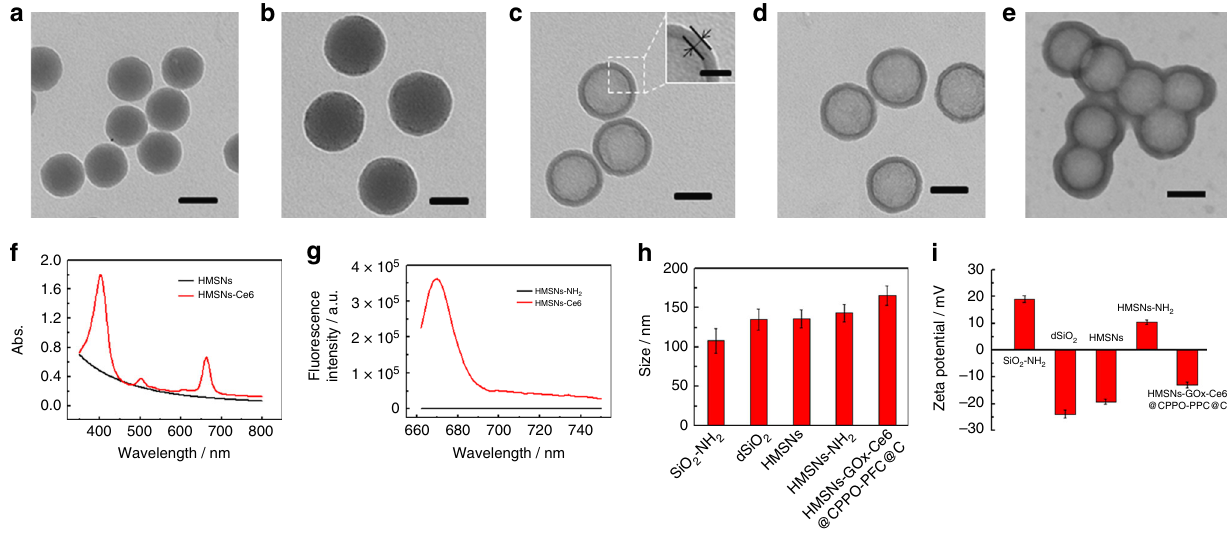
Fig. 2 Characterization of the biomimetic nanoreactor. TEM images of SiO 2 -NH 2 ( a ), dSiO 2 ( b ), HMSNs ( c ), HMSNs-NH 2 ( d ), and HMSNs-GOx- Ce6@CPPO-PFC@C ( e ). Scale bar in the inset of ( c ) is 20 nm and others are 50 nm. f Absorption spectra of HMSNs and HMSNs-Ce6. g Fluorescence spectra of HMSNs and HMSNs-Ce6. Hydrodynamic size distributions ( h ) and zeta potentials ( i ) of the